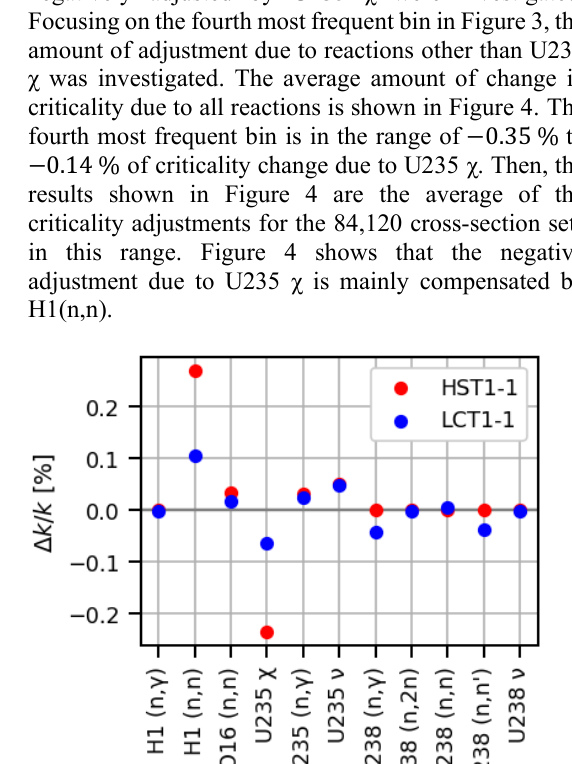
Figure 3. The frequency of the change in criticality by U235 χ for the 593,340 cross-section sets (HST1-1) The 179,994 cross-section sets whose criticality is negatively adjusted by U235 χ were investigated.